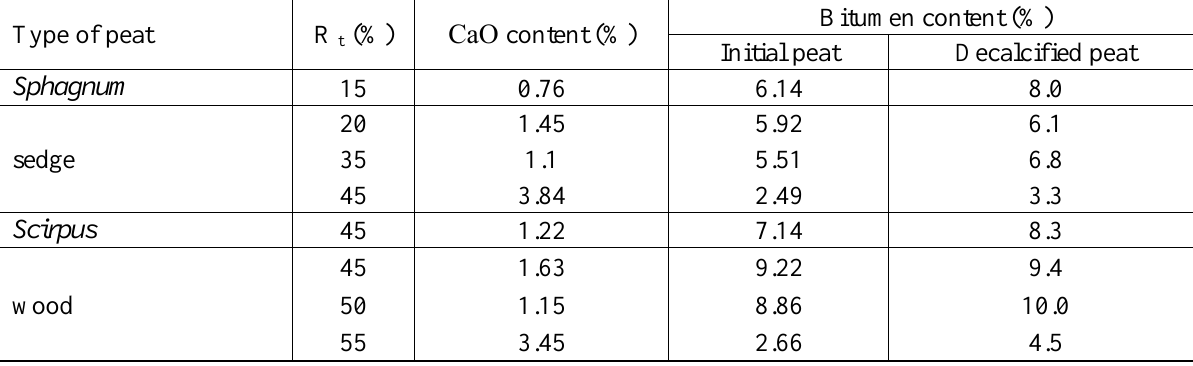
Table 2. Bitumen content values for fen peat with various contents of CaO in ash. Source: Bel’kevich et al .